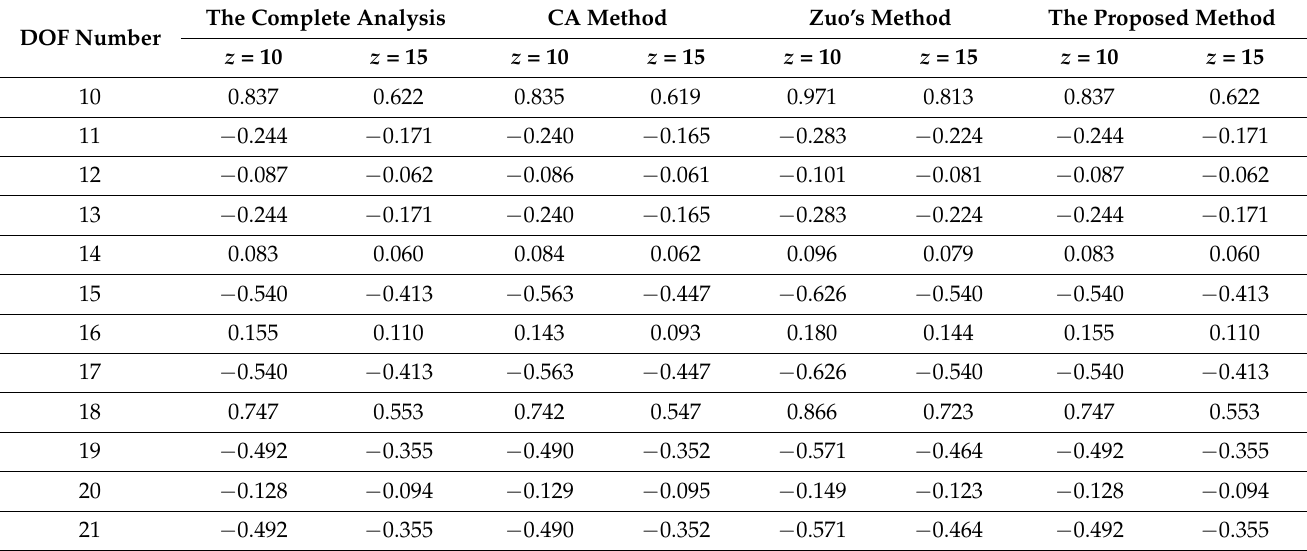
Table 7. Displacement sensitivities for modification type 1 when z = 10 and z = 15 ( × 10 − 5 ).